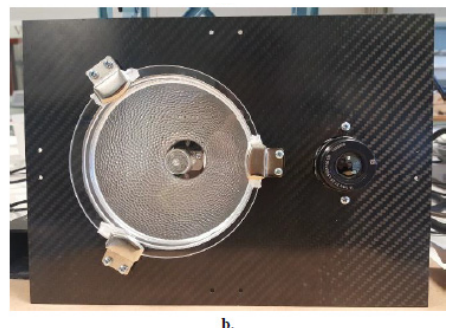
Figure 2. Top ( a ) and bottom ( b ) view of infrared thermography (IRT) module complete with IR sensor and excitation source with 300 W halogen lamp, IR-filtering eyepiece, and reflector resting on carbon fiber reinforced polymer (CFRP) plate. The total weight of the module including cabling is 407 g, dimensions of ca L × W × H: 200 × 150 × 100 mm 3 , enabling extreme compactness, portability, and maneuverability.